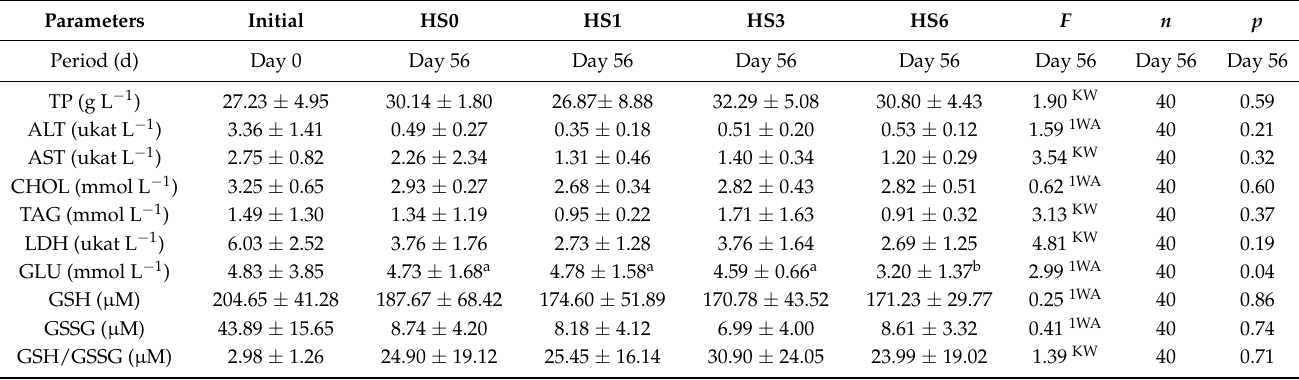
Values are presented as mean ± SD. Number of considered experimental units ( n ). One-way ANOVA ( 1WA ) or Kruskal-Wallis ( KW ) test results are power of test ( F ), and level of significance ( p ). Different superscripts (a, b) indicate significant differences (Tukey HSD test, p < 0.05) within one